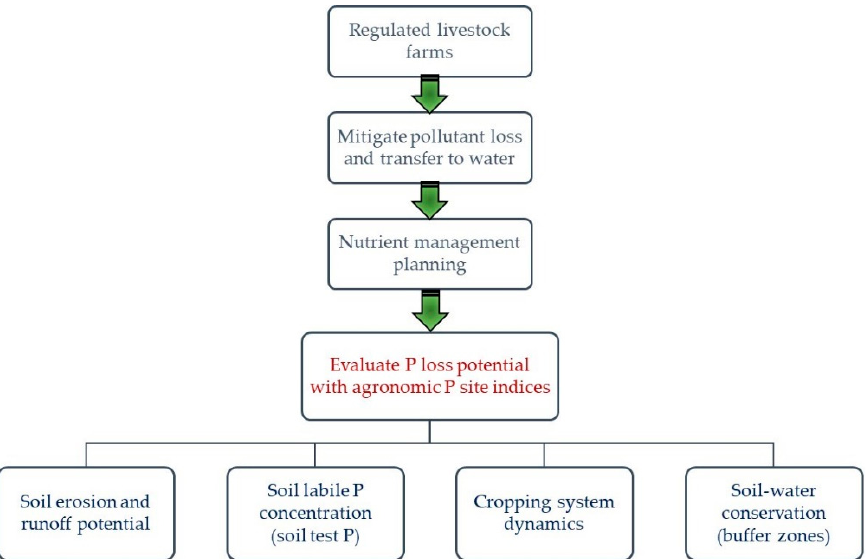
Figure 1. US livestock farms subject to federal Clean Water Act regulations or receiving grant monies must implement cropland nutrient management plans (NMPs) to reduce nonpoint source pollutant loss to open waters. Agronomic P site indices (PSIs) capture soil and management factors affecting annual P loss potential in overland flows and are used to rank P loss potential by